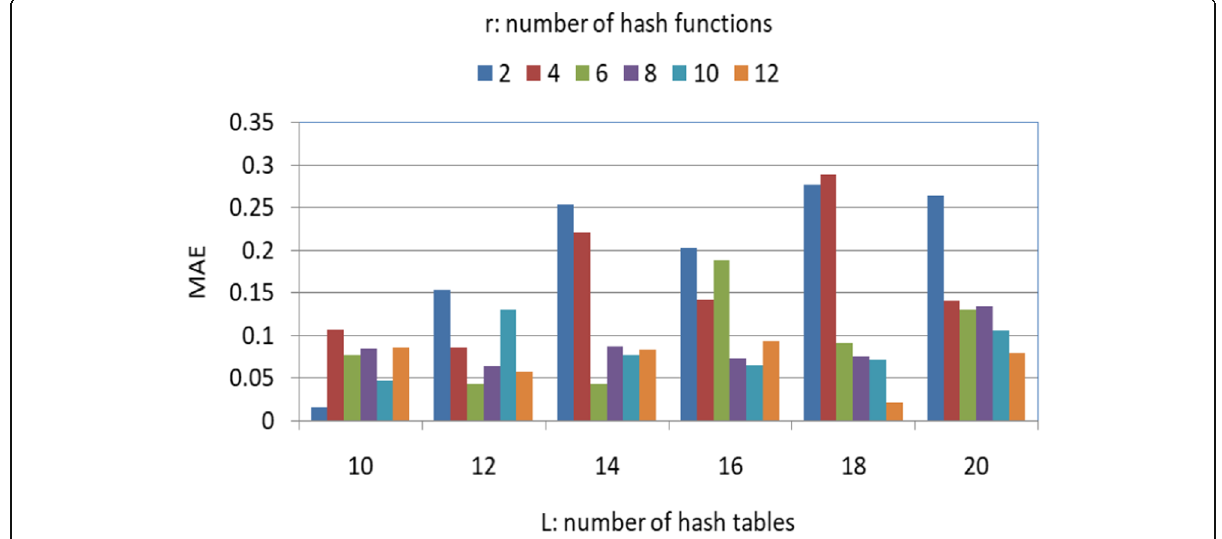
Fig. 3 Recommendation accuracy of Rec LSH* (w.r.t. r and L ). Detailed legend: r : number of hash functions (2, 4, 6, 8, 10,